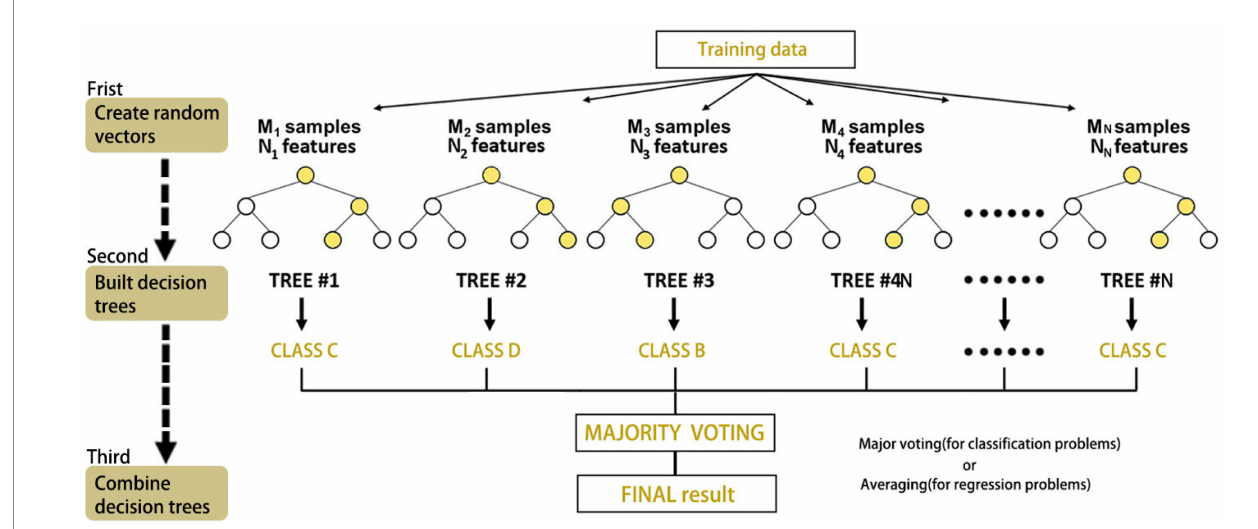
FIGURE 4 Depiction of the BSV-based method for estimating streetscape greenery at eye level.